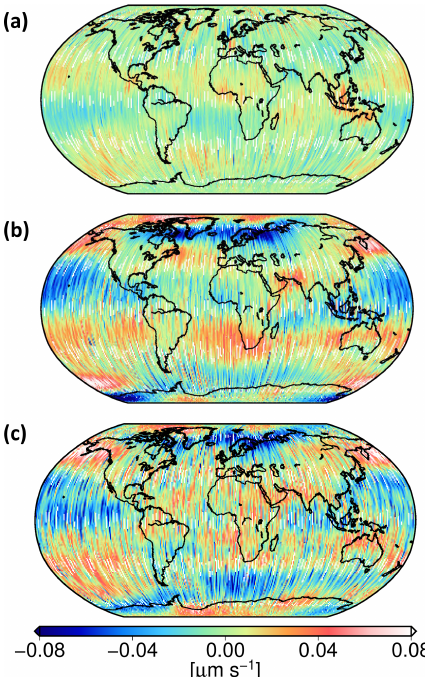
Figure 14. Spatial analysis of long timescale propagated errors from (a) AOD1B RL05 model and (b) EOT11a model, compared to (c) long timescale details of real residuals. The values are plotted with respect to the GRACE-A ground track for February